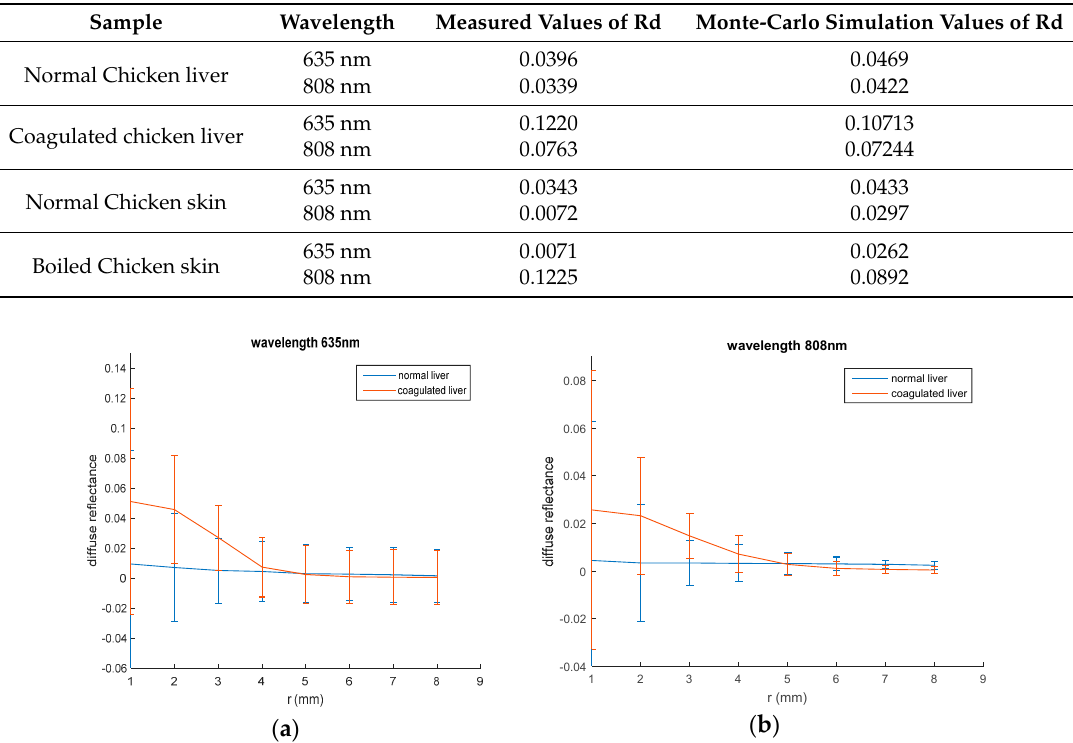
Table 2. Monte-Carlo Validation.